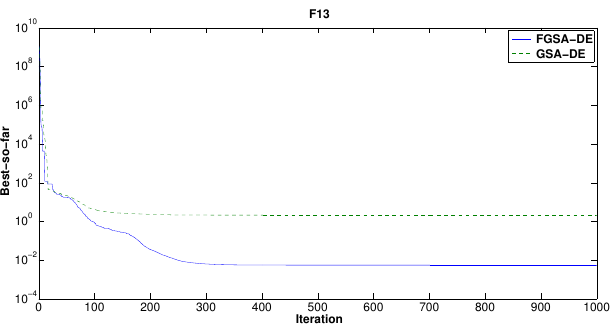
Figure 14. Comparison of the performance of FGSA-DE and GSA-DE for minimization of F 13.